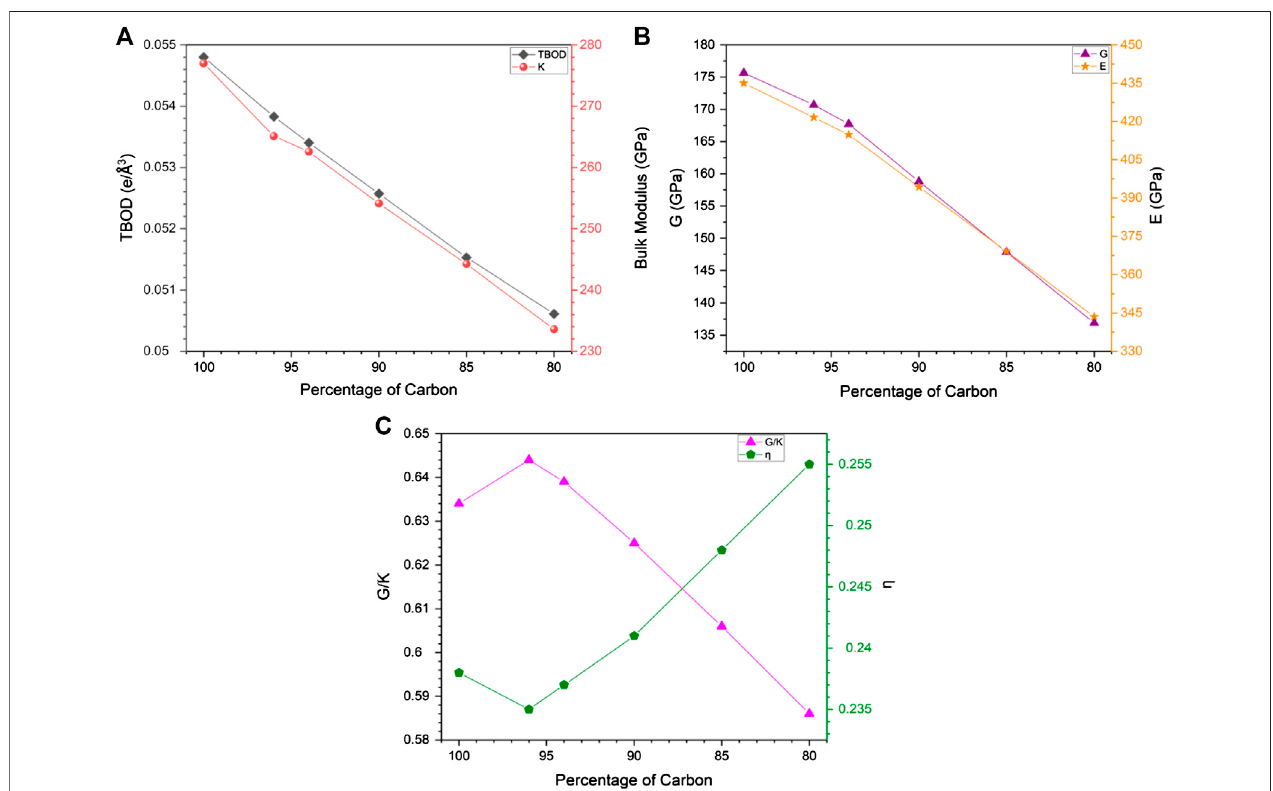
FIGURE 7 | Correlation of percentage of carbon with: (A) TBOD and bulk modulus; (B) shear modules and Young ’ s modulus; (C) G/K and Poisson ’ s ratio.